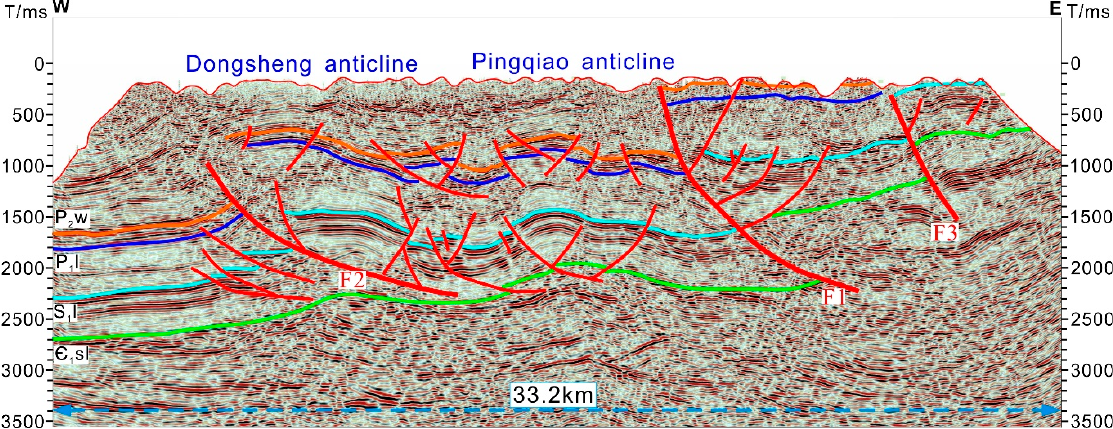
Figure 4. Seismic interpretation profile in NC 3D survey. (F1: Qiyueshan fault, F2: Longjiqiao fault, F3: Daqian fault). F3: Daqian fault).